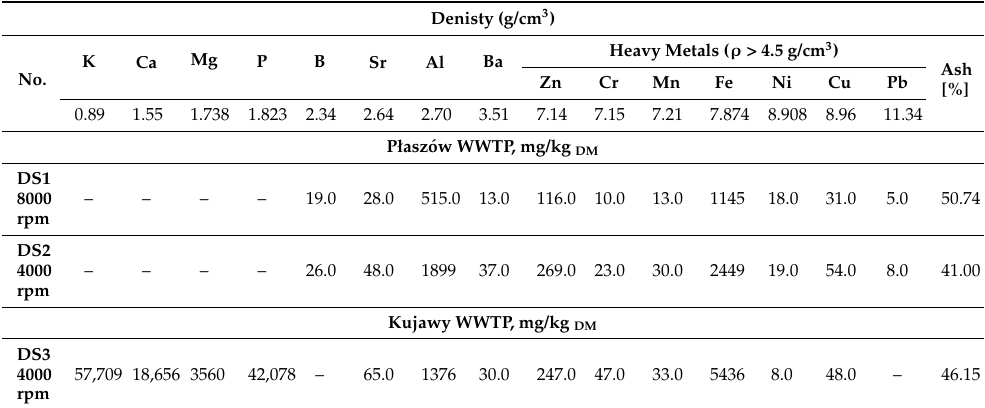
Table 7. Inorganic micropollutants in the digested sludge effluents centrifuged at 4000 rpm and at 8000 rpm.